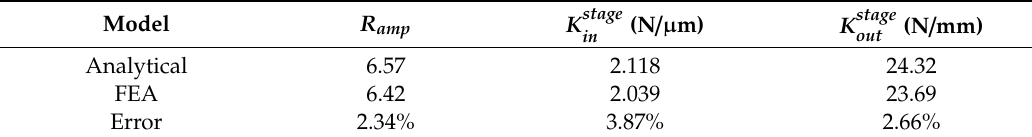
Table 3. Performance of the proposed positioning stage.